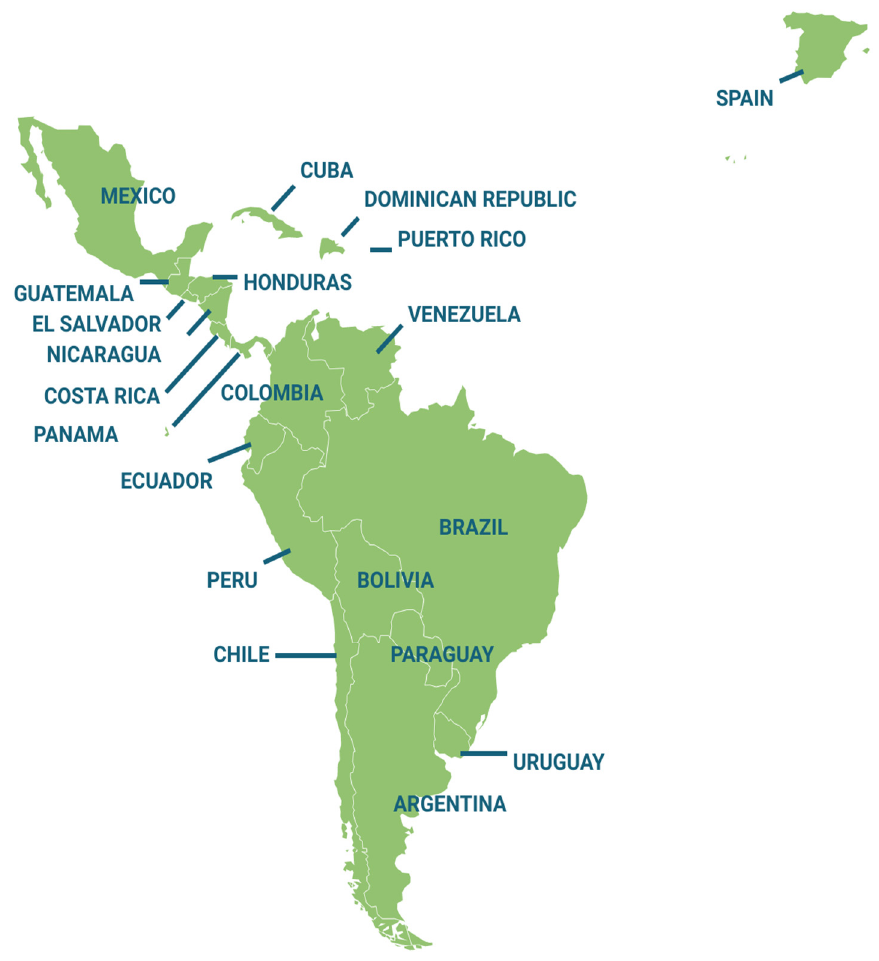
Figure 3. Countries participating in the research.